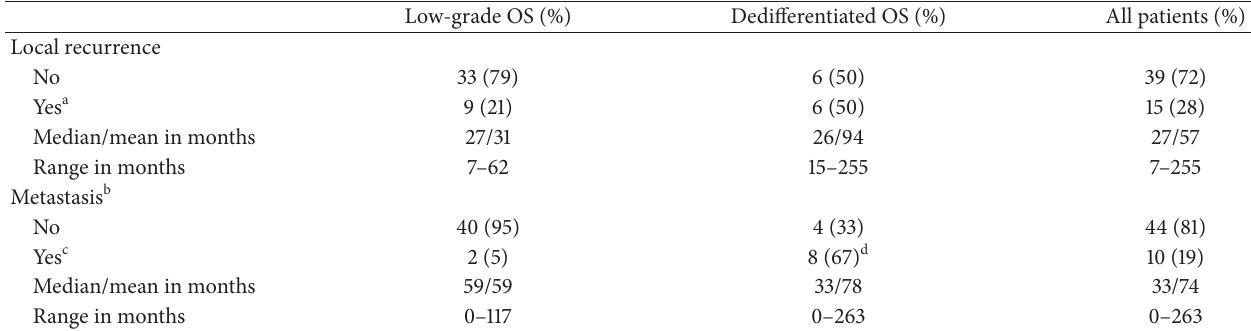
Table 3: Patients with local recurrence and/or metastasis at diagnosis or during follow-up among 54 low-grade or dedifferentiated osteosar- coma (OS) patients.